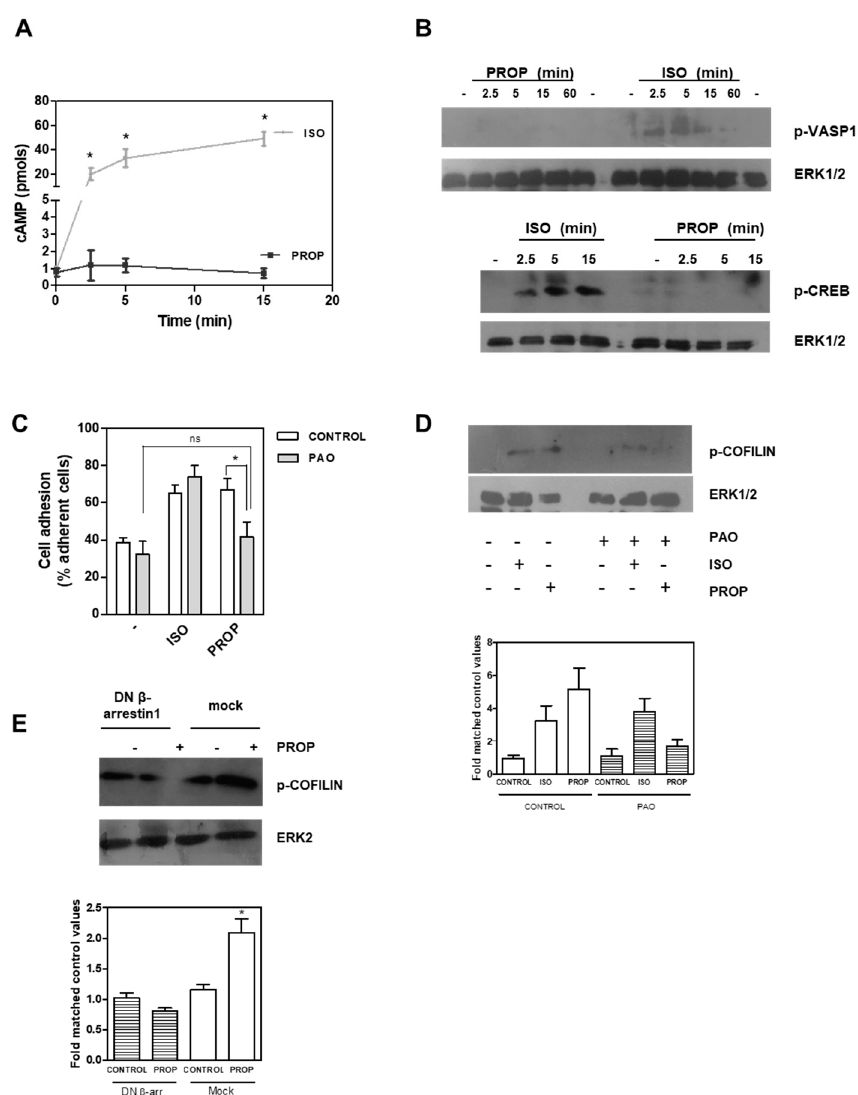
Figure 5. ( A ) Time course of intracellular cAMP production in MCF-10A cells in the presence of 3-isobutyl-methylxantine after isoproterenol (ISO) or propranolol (PROP) incubation. ( B ) ISO but not PROP induces a time dependent phosphorylation of cAMP response element-binding protein (CREB) and vasodilator-stimulated phosphoprotein (VASP) proteins measured by Western Blot. ( C ) E ff ect of phenylarsine oxide (PAO) on ISO and PROP induced-cell adhesion. ( D ) Western Blot of p-COFILIN after ISO and PROP treatment in the presence ( + ) or absence ( − ) of PAO. ( E ) Western Blot of p-COFILIN after PROP treatment in cells transfected with β -arrestin 1 dominant–negative (DN) or with the empty vector (mock). ERK1 / 2 or ERK2 were used as loading controls. Statistical significance was assessed using ANOVA Bonferroni test. * p < 0.05, n.s: non-significant di ff erence. Experiments were repeated three times with similar results.